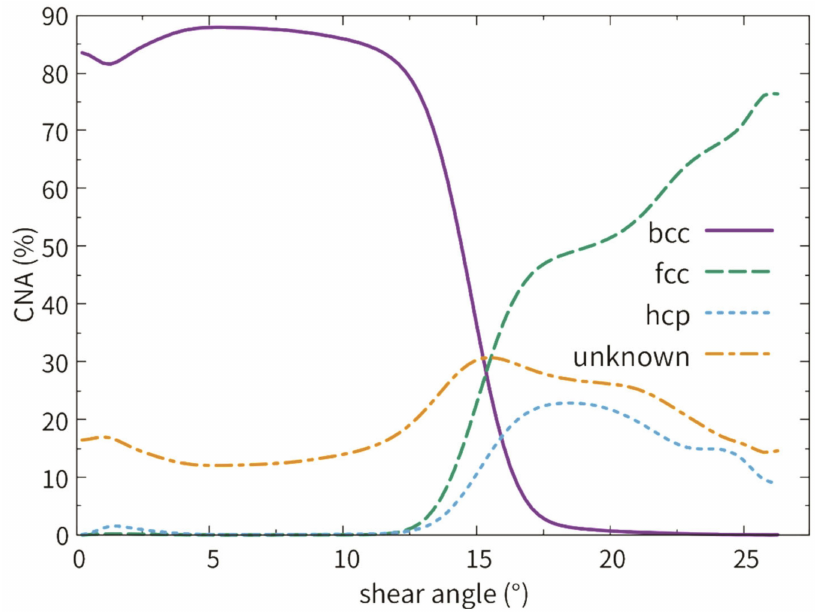
Figure 10. Fractional phase contents of film 3 with (111) bcc free surface as a function of shear angle at a temperature of 800